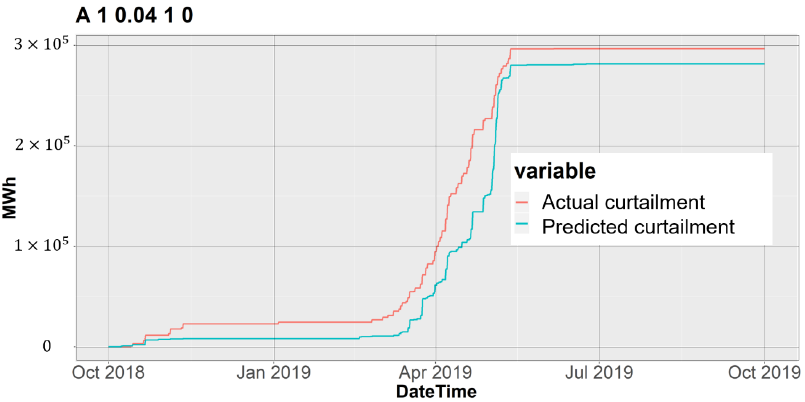
Figure A2. Calibration result—A1, 0.04, 1, 0. The red line indicates the actual cumulative curtailments and the blue line represents the predicted curtailments.